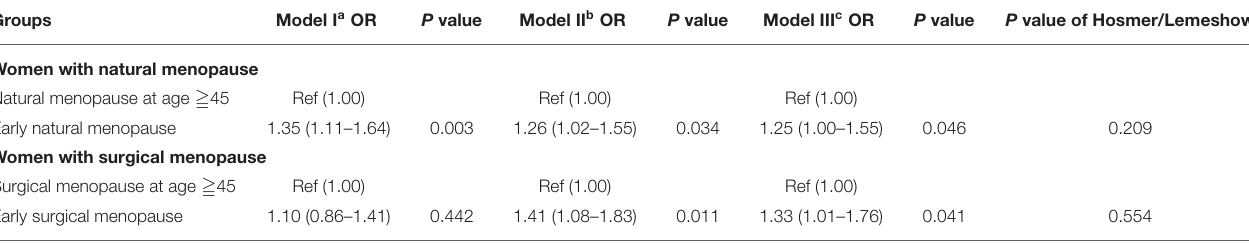
TABLE 2 | The association of early menopause and CKD prevalence by logistic